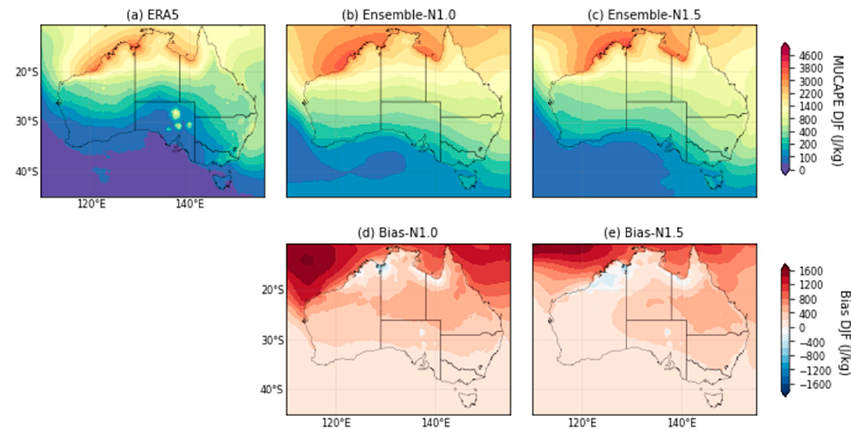
are the biases of N1.0 and N1.5 from ERA5, respectively. Unit: J kg − 1 .